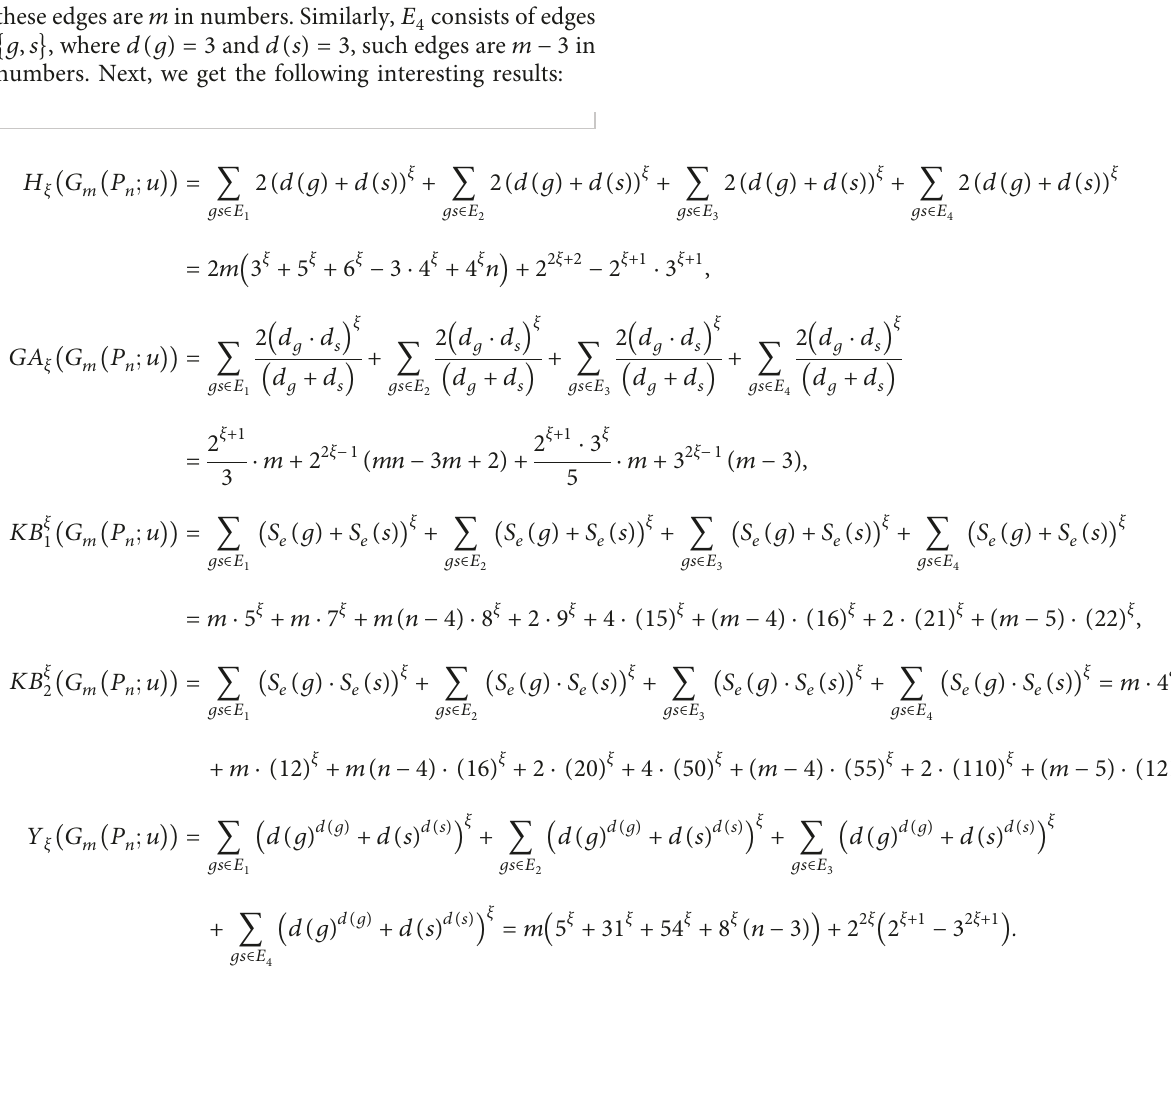
Figure 1: Bridge graph over path P